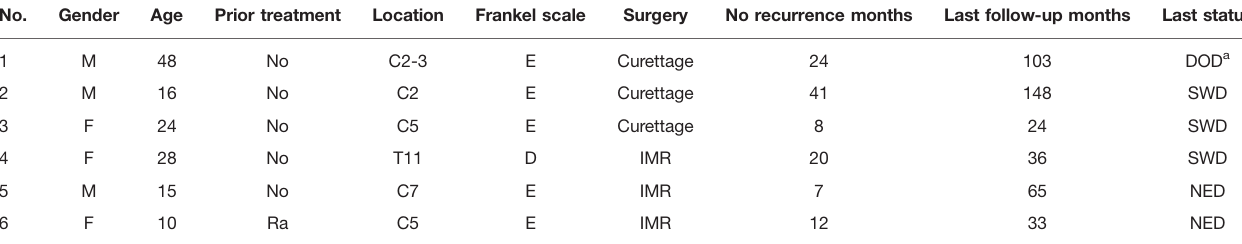
FIGURE 3 | Case 6. A 10-year-old female patient with a history of neck pain over 6 months. An irregular and heterogeneous lesion was located in the C5 right pedicel and transverse process, vertebral body, and lamina, with right vertebral artery extension. She initially underwent radiofrequency ablation; however, computed tomography (CT) examination at the 5-month follow-up revealed lesion enlargement. Subsequently, the patient underwent intralesional marginal resection through a posterior approach. Local recurrence was identi fi ed by CT at the 12-month follow-up. She underwent a C5 vertebrectomy through an anterior approach. No recurrence was observed at the 21-month follow up after the second surgery. ( A ) Posteroanterior radiography before radiofrequency ablation. ( B,C ) Preoperative axial and coronal CT scans before radiofrequency ablation. ( D ) T2-weighted magnetic resonance imaging (MRI) scan at 5 months after radiofrequency ablation. ( E,F ) Axial and coronary CT scan at 5 months after radiofrequency ablation. ( G ) Posteroanterior radiography 1 week postoperatively. ( H ) Axial CT scan 1 week postoperatively. ( I ) Axial CT scan 12 months postoperatively. ( J ) T2-weighted MRI scan 12 months postoperatively. ( K ) Posteroanterior radiography 1 week after the second surgery. ( L ) T2-weighted MRI CT scan 21 months after the second surgery. TABLE 3 | Study characteristics of recurrence